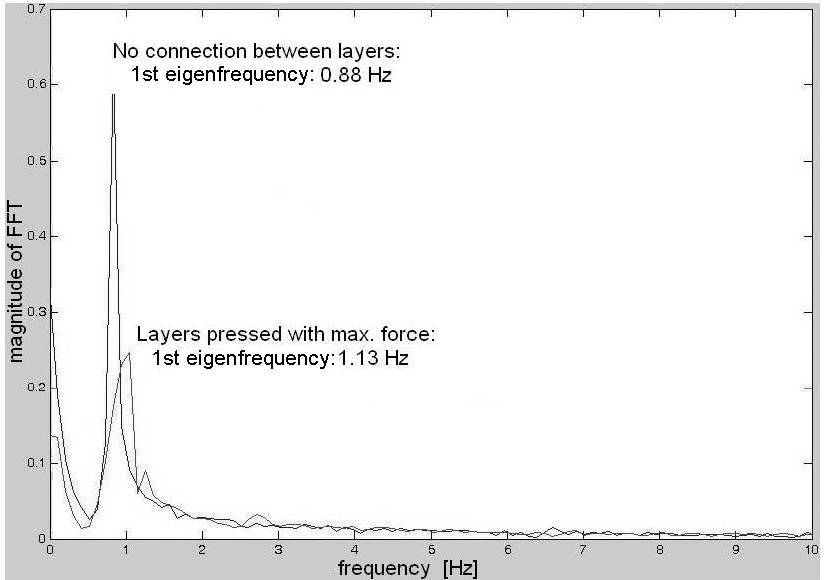
Fig. 14. 1st eigen frequency shift between disconnected and connected layers.